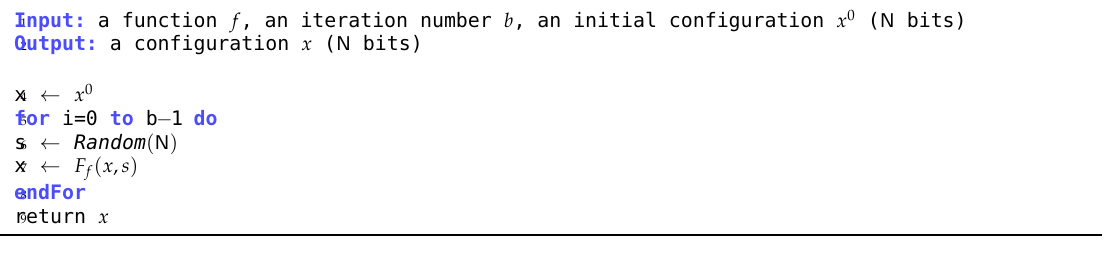
Algorithm 3: Chaotic PRNG scheme.